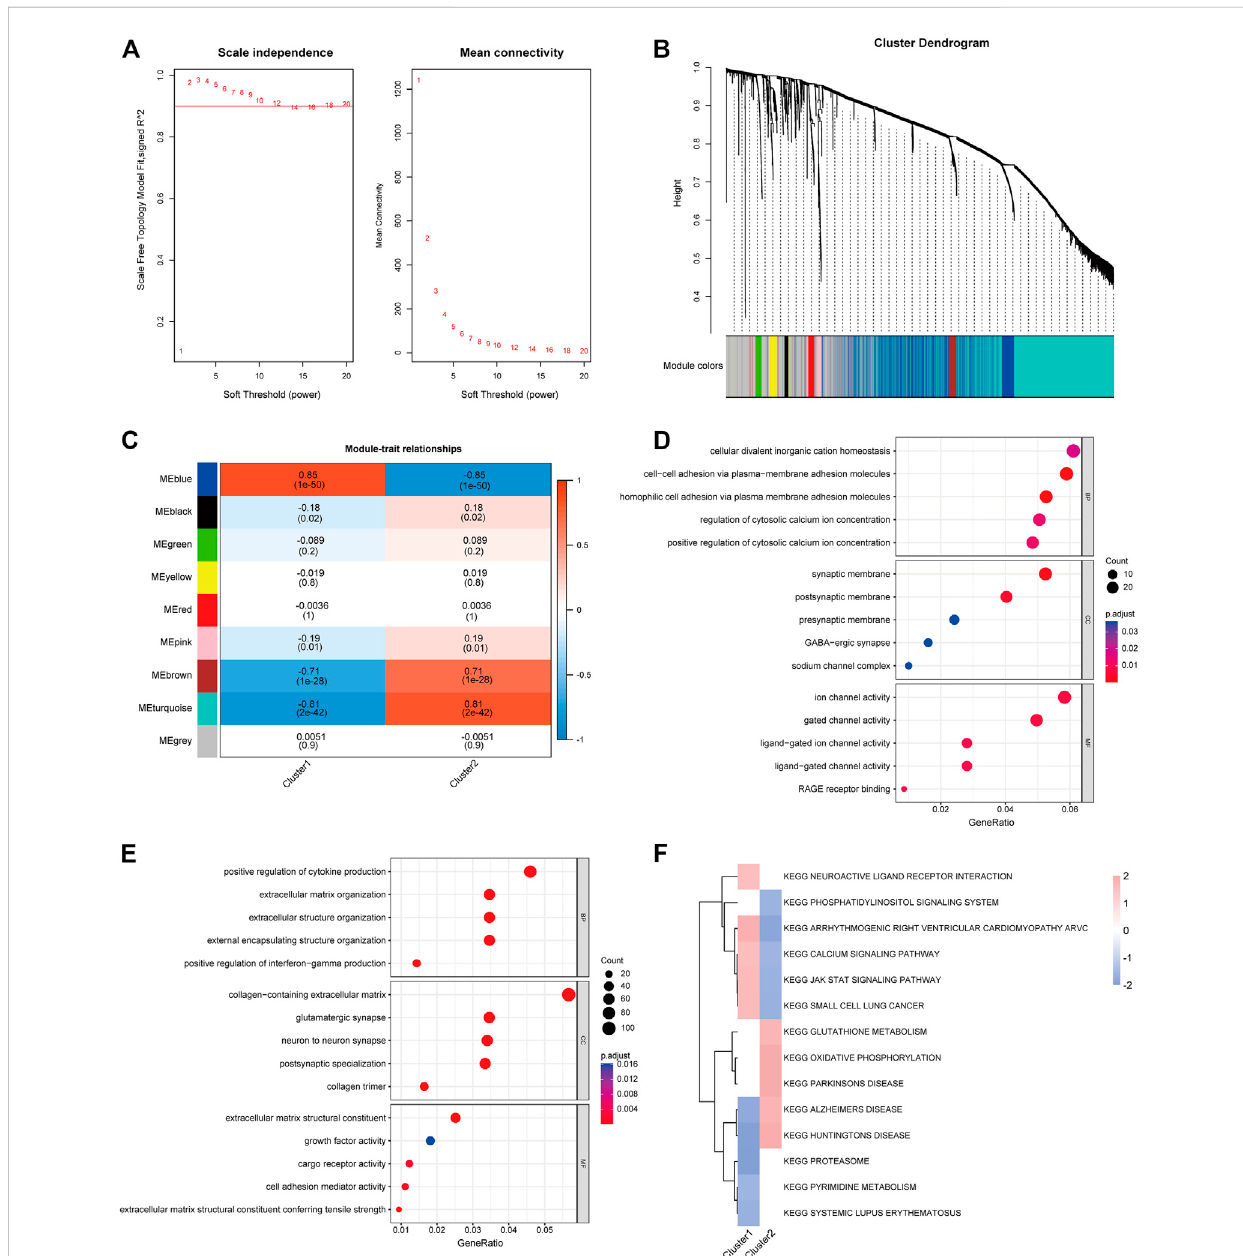
FIGURE 7 Co-expression pattern identi fi cation and enrichment analysis. (A) Selection of soft threshold power. (B) Tree diagram based on hierarchical clustering under optimal soft thresholds. (C) Heat map of correlations between nine modules and clinical features (CRGcluster C1, CRGcluster C2). (D) GO enrichment analysis of CRGcluster C1 MEblue module. (E) GO enrichment analysis of CRGcluster C2 turquoise module. (F) FGSEA enrichment analysis was performed on both clusters with a cut-off value of p <